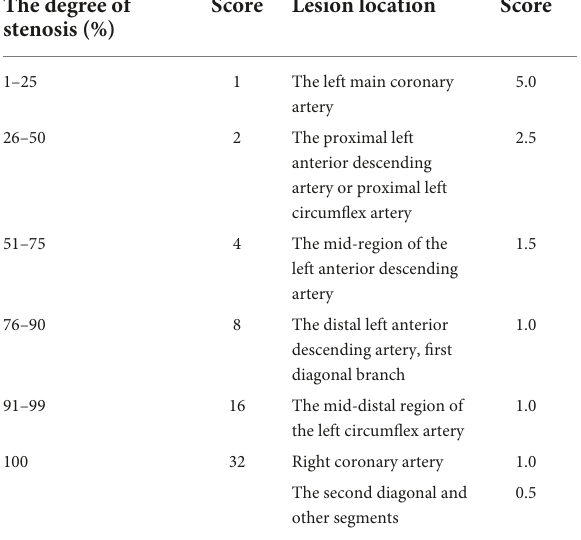
TABLE 1 The Gensini score system.